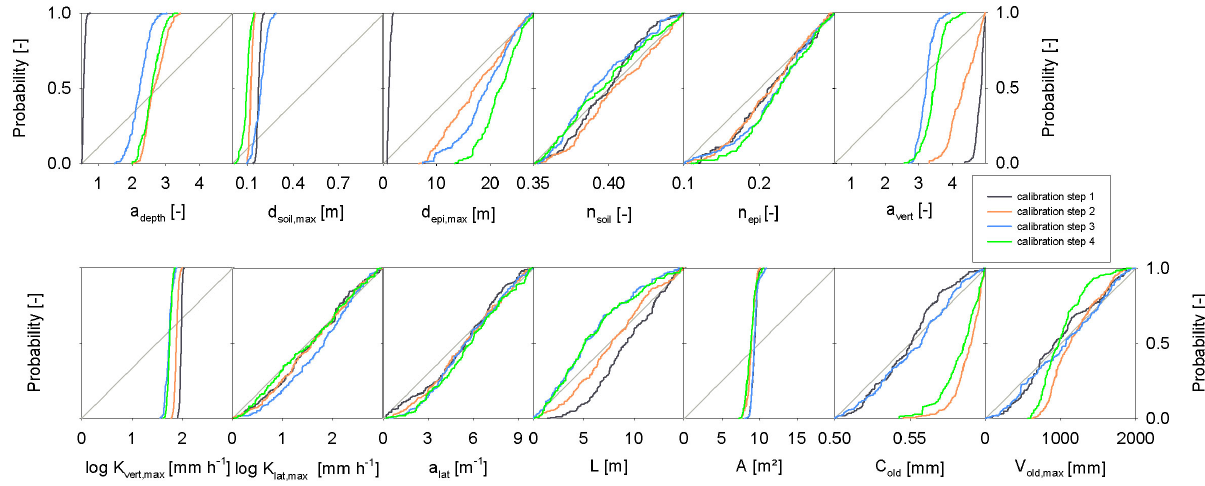
Fig. 5. Cumulative parameter distributions for all four calibration steps.